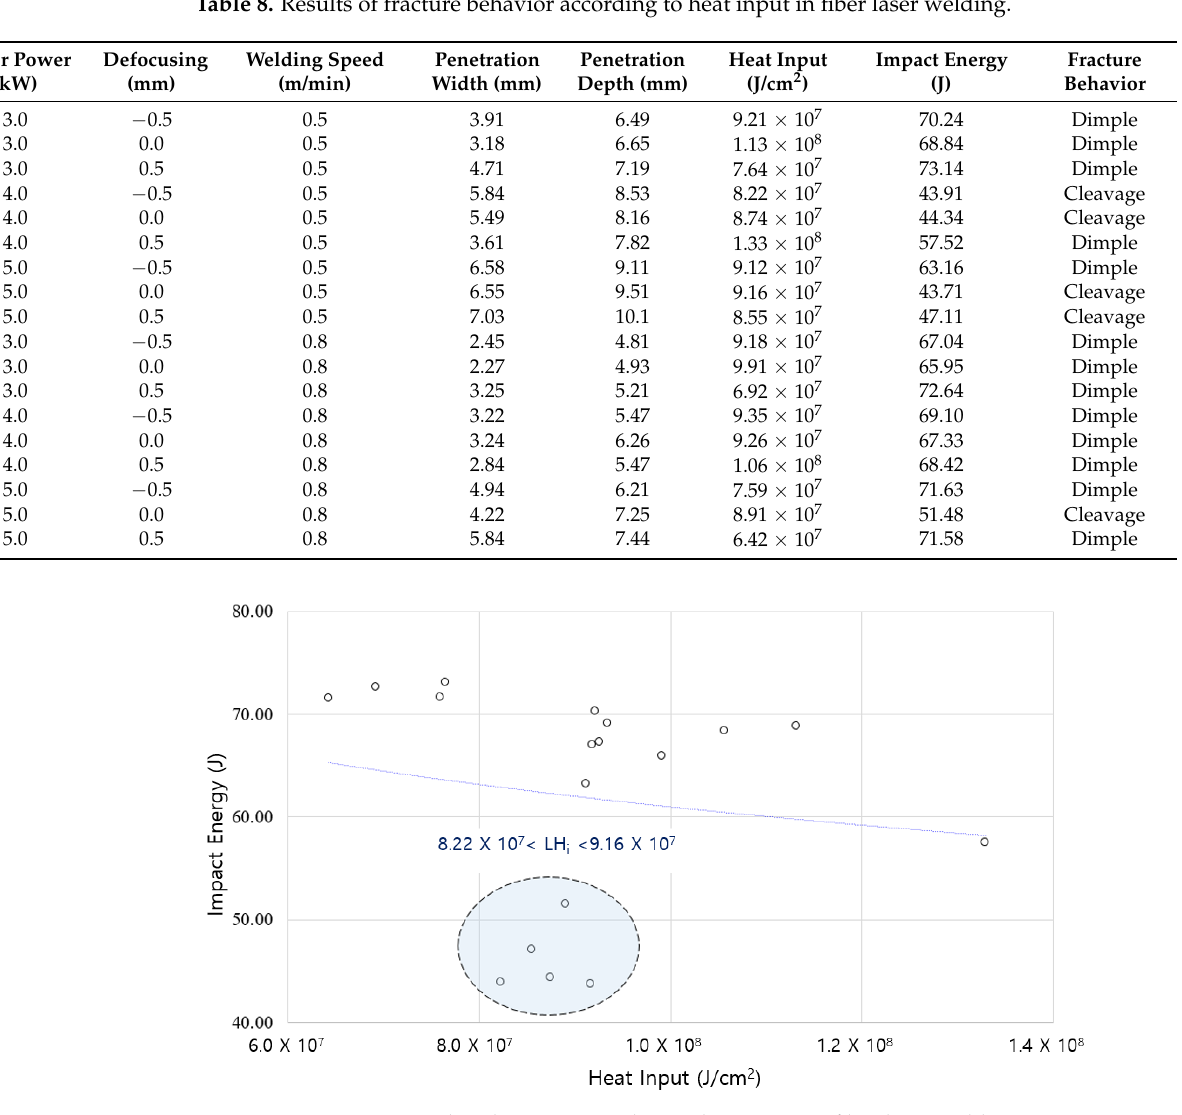
Table 9. Brittle fracture behavior data for discriminant analysis in fiber laser welding.